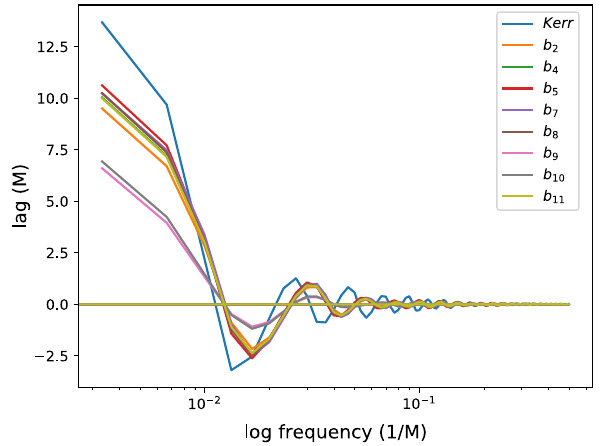
Fig. 7 Lag vs frequency for different b i = 5. The spin parameter is 0 . 95 and viewing angle is 45 ◦ . The height of the corona is 10